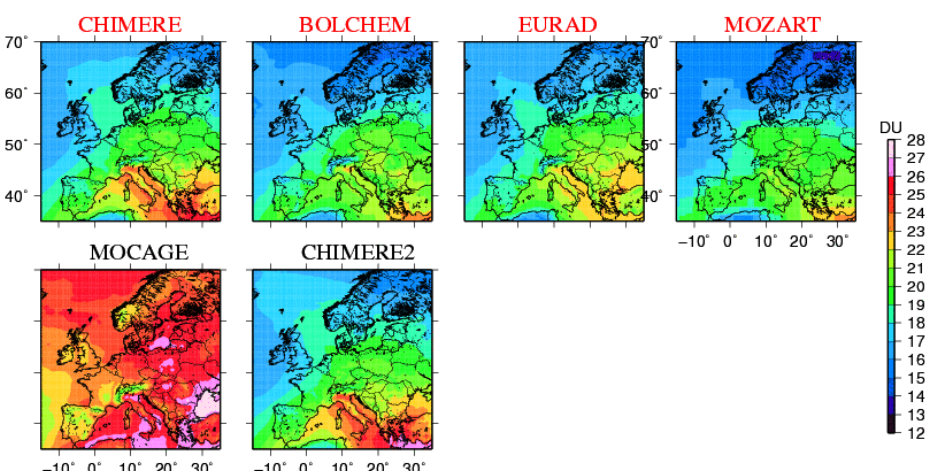
Fig. 5. 0–6km raw ozone partial columns (in Dobson Unit) averaged over the summer 2008